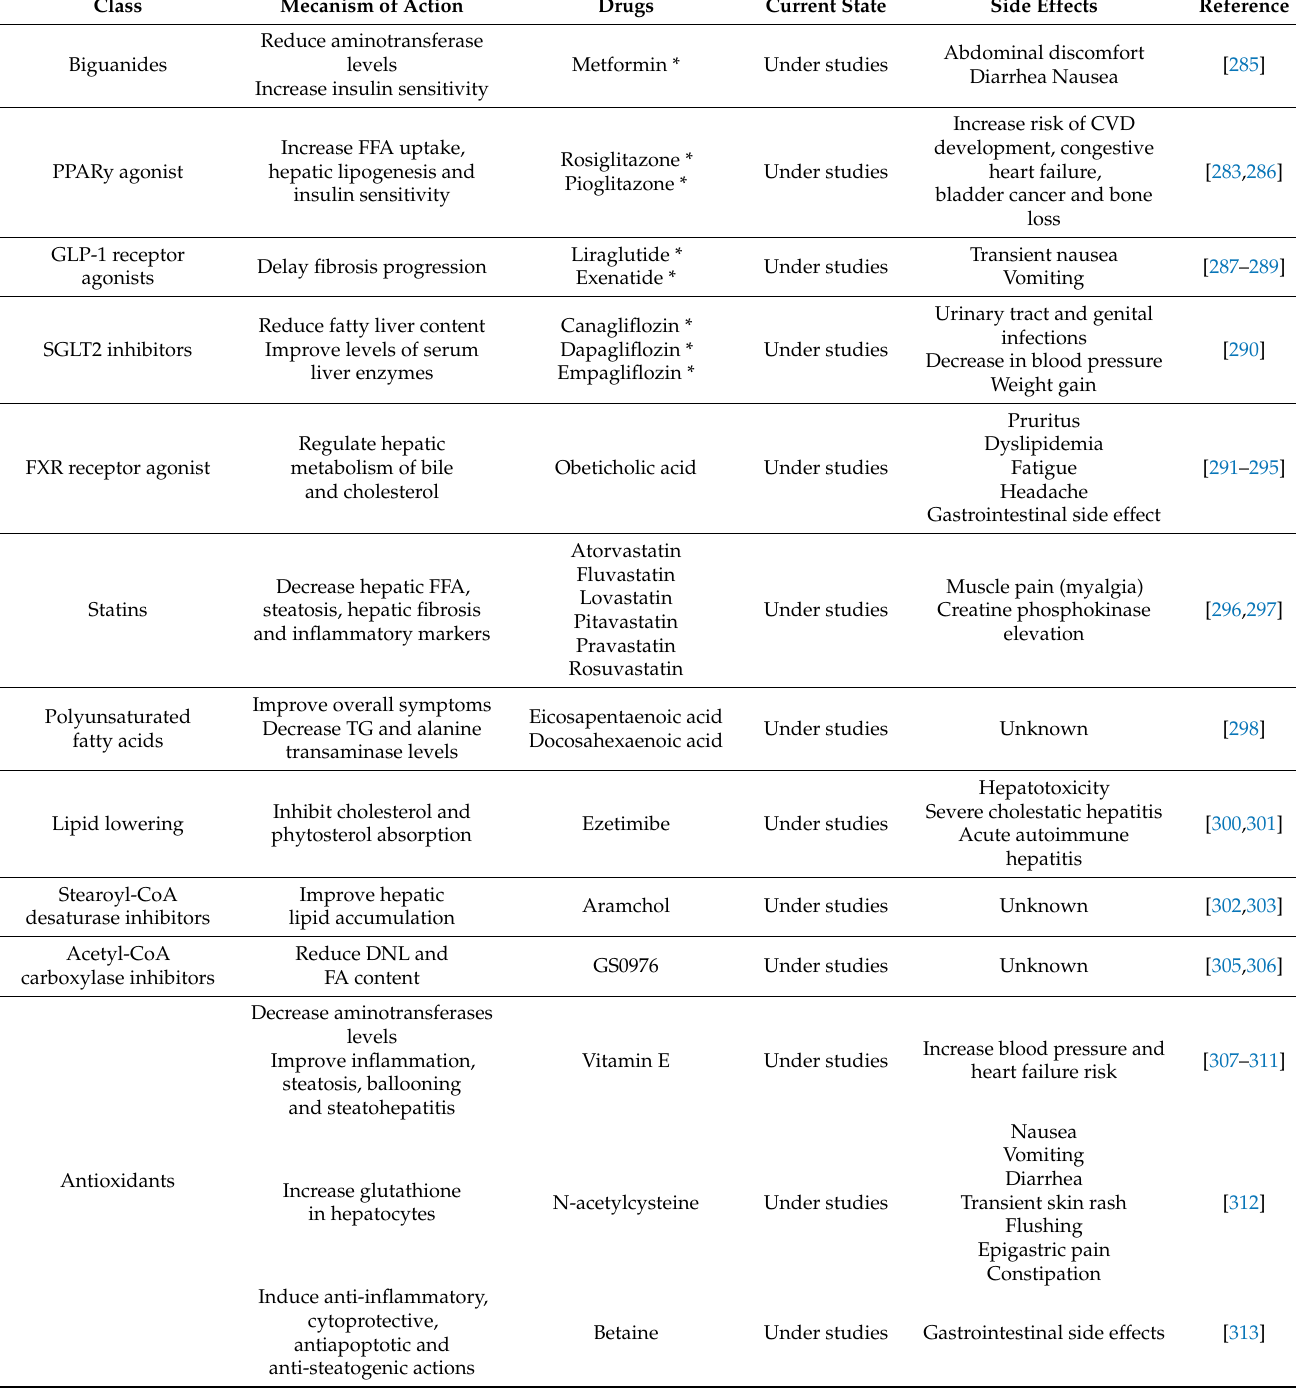
Table 3. Pharmacological treatments for metabolic associated fatty liver disease. The compounds are divided into class, mechanism of action, drugs examples, current state of application, and its side